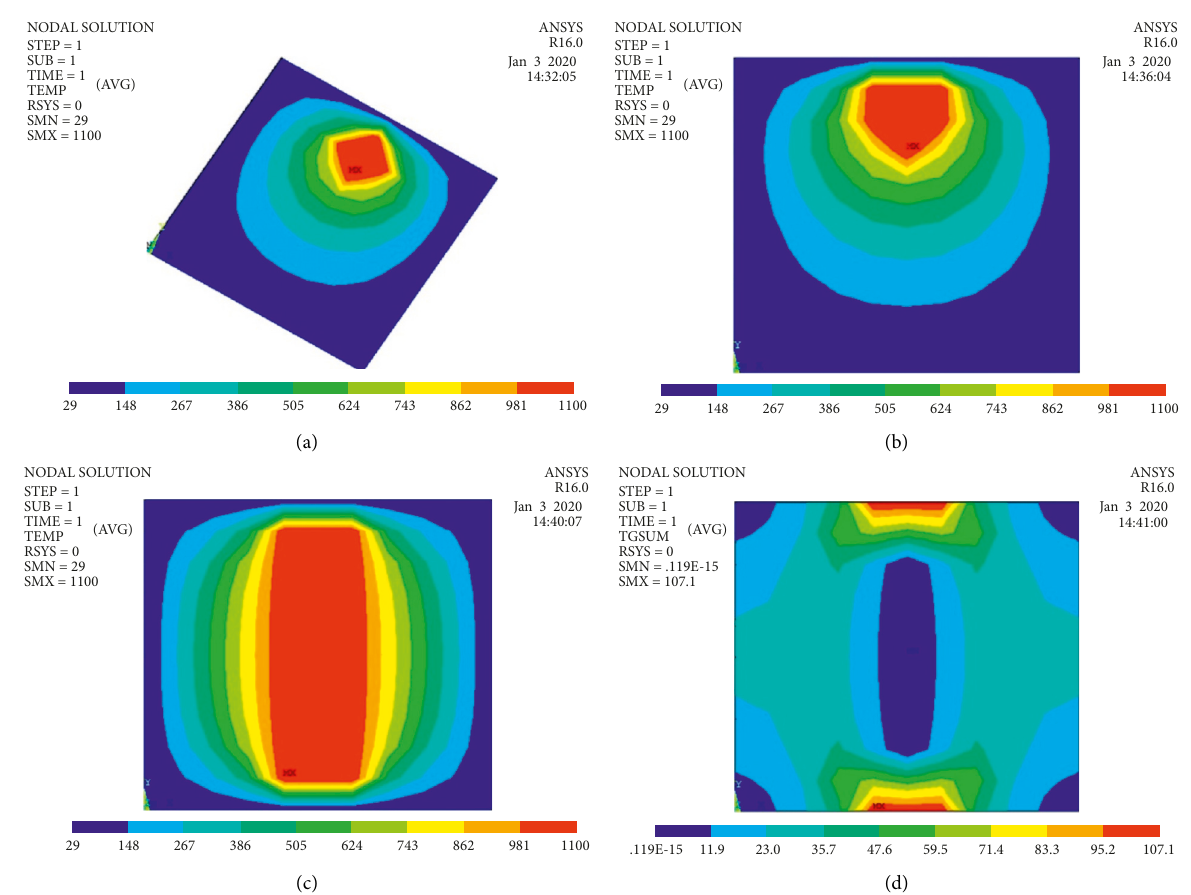
Figure 13: Temperature distribution during FSW using the ANSYS